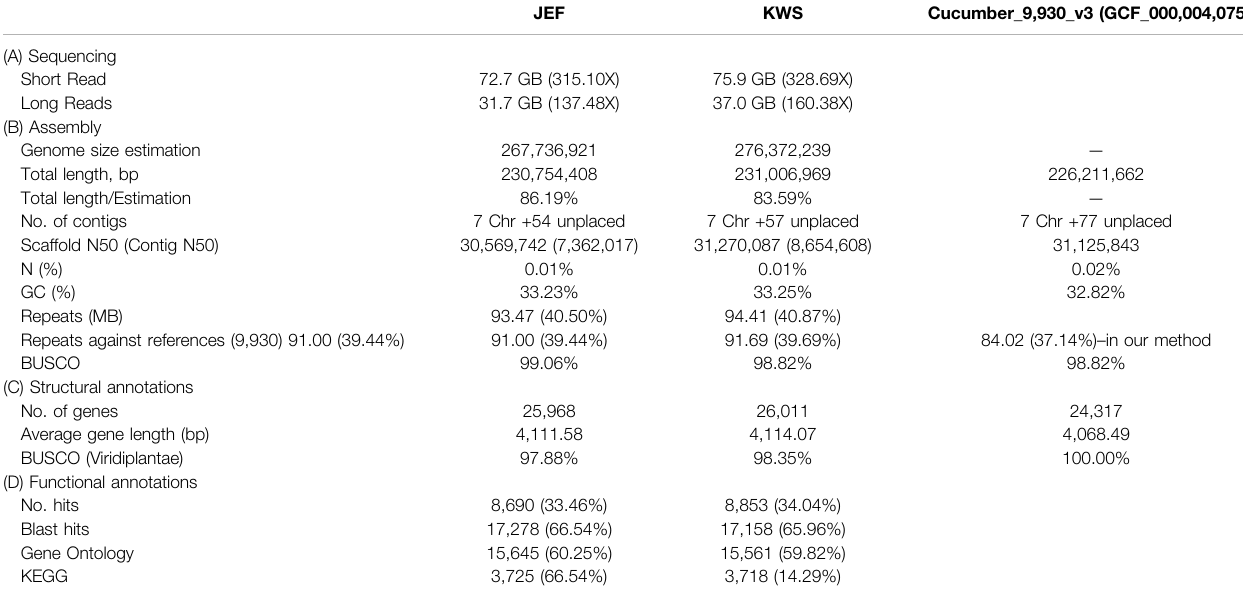
TABLE 1 | Summary of the sequencing to annotation of the cucumber draft genomes along with the